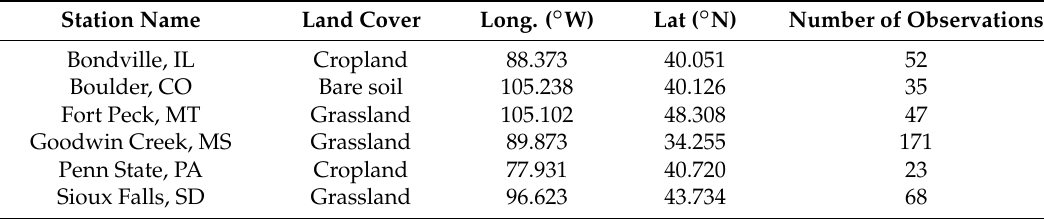
Table 2. Specifications of six Surface Radiation Budget Network (SURFRAD)